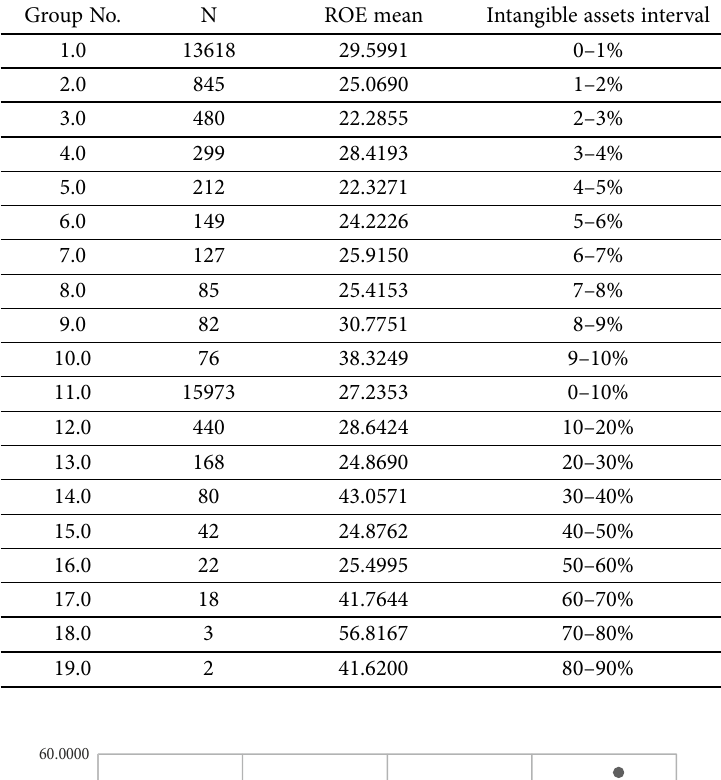
Table 1A. ROE mean analysis: average ROE based on intangible assets intervals